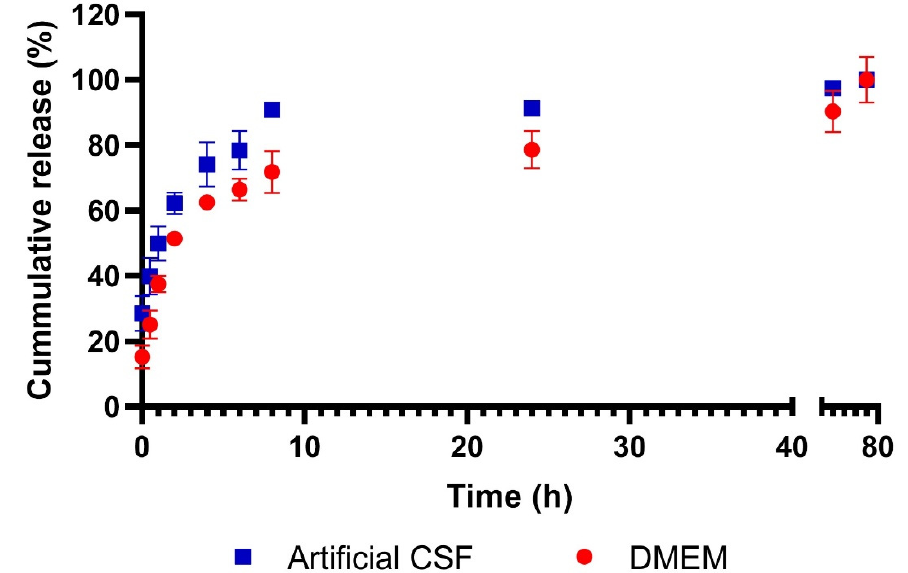
Figure 2. Cumulative lactate release from LSNP. Nanoparticles were resuspended in DMEM and artificial CSF, obtaining samples over 72 h. The percentage of lactate released was calculated by spectrophotometry with FeCl 3 reaction assay. The graph shows the mean ± SEM of 3 independent experiments in triplicate in artificial CSF (blue) and DMEM (red).